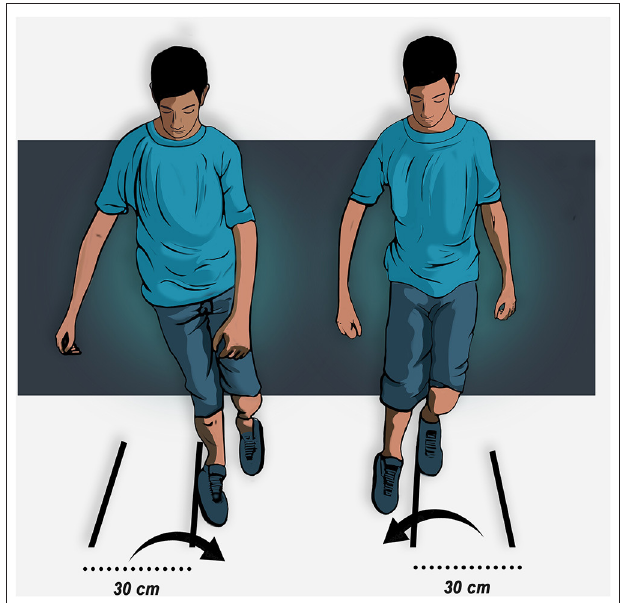
FIGURE 3 | Side hop test of the right limb.